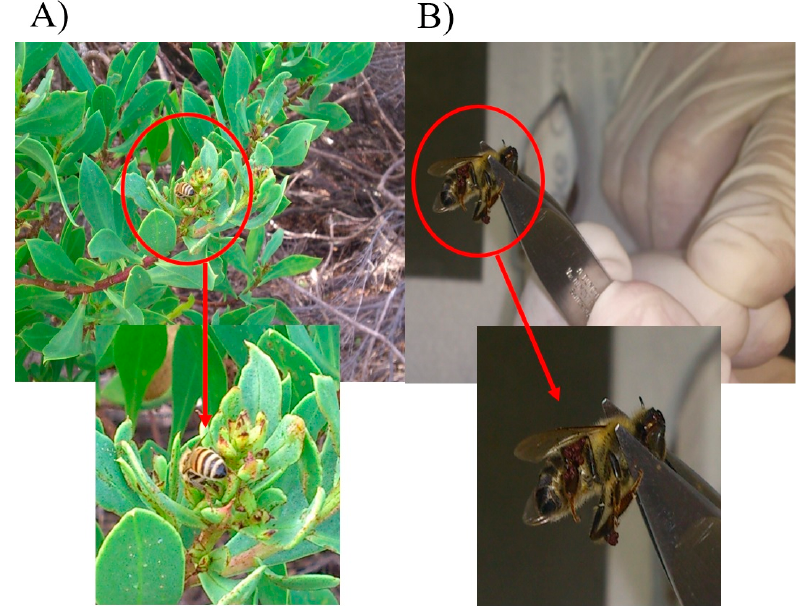
Figure 3. ( A ) Propolis collection by bees from resinous leaves of Myoporum insulare ; ( B ) Laboratory analysis of the bee legs with propolis collected from Myoporum insulare leaves surface.